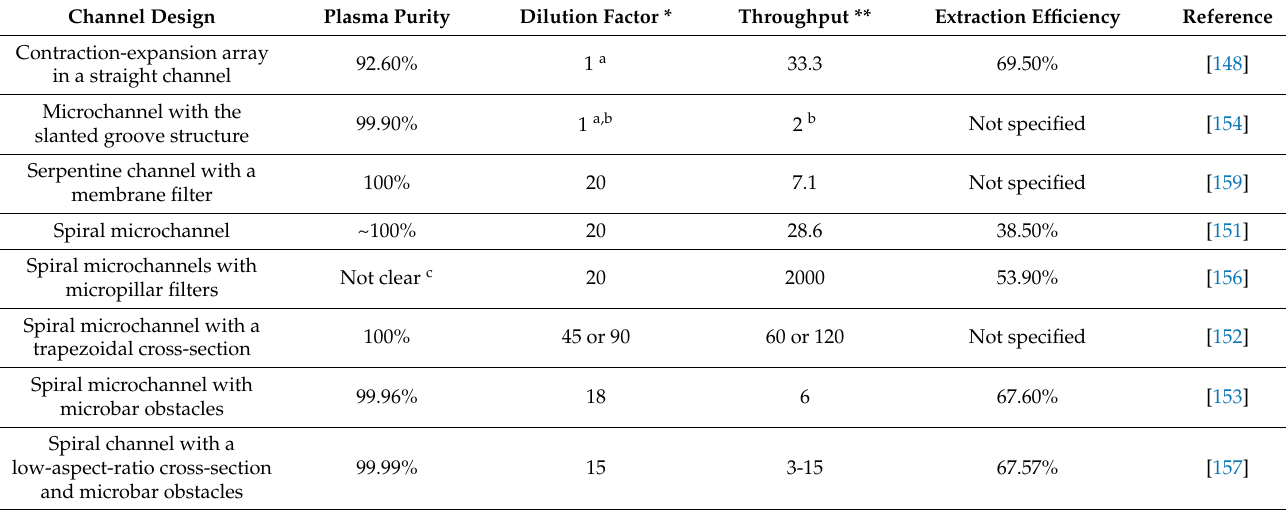
Table 2. Summary of literature on inertial microfluidic plasma extraction investigated in this review paper. Key performance metrics, plasma purity, dilution factor, throughput, extraction efficiency, and channel design are listed with